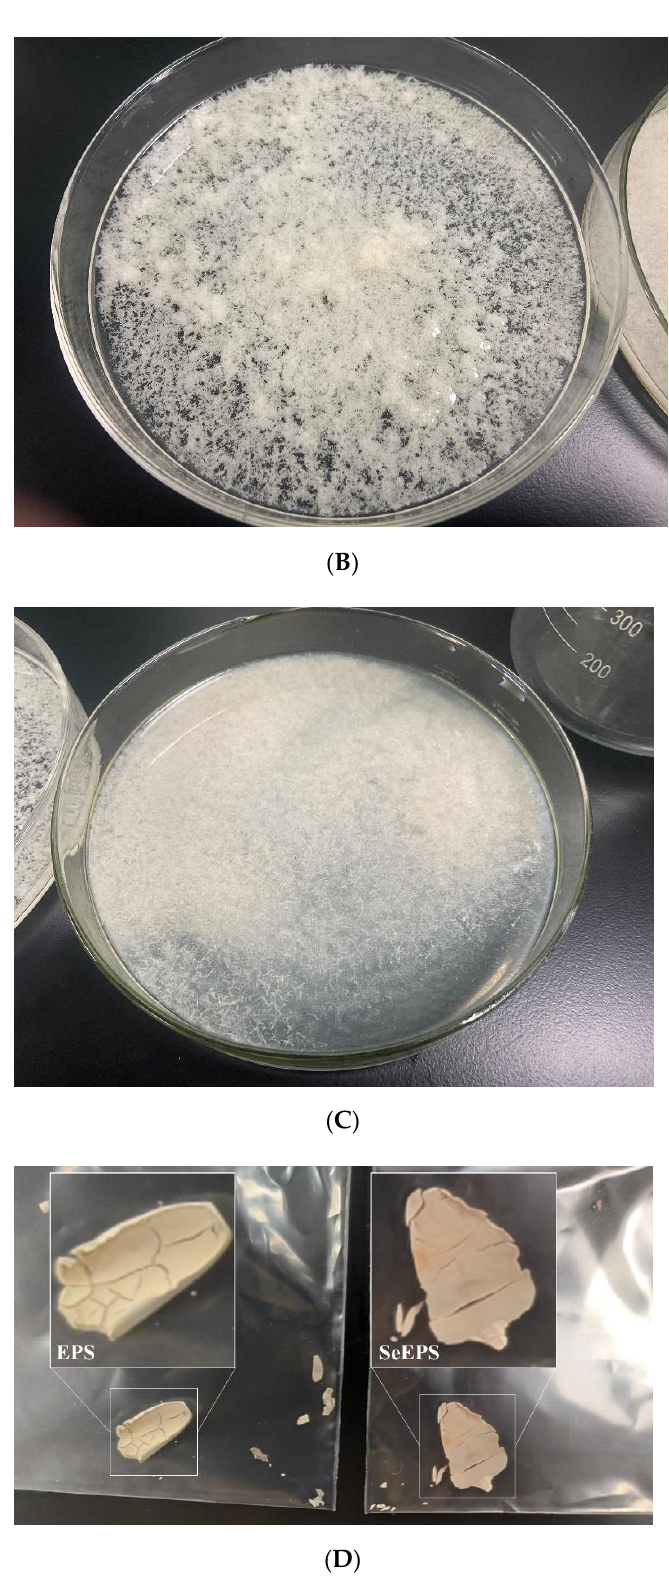
Figure 1. The whole process of sample preparation. ( A ) EPS and SeEPS after fermentation, ( B ) EPS after ethanol precipitation and centrifugation, ( C ) SeEPS after ethanol precipitation and centrifugation and ( D ) EPS and SeEPS after ultrasonication and lyophilization.